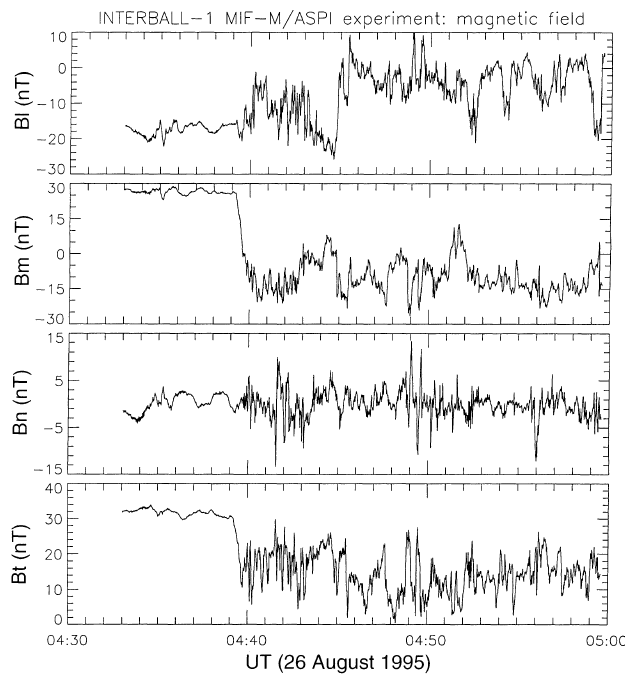
Fig. 5. High-latitude magnetopause crossing 26 August 1995. Mag- netic field components B , B , B and total value B t in the boundary l m n frame of reference. See text